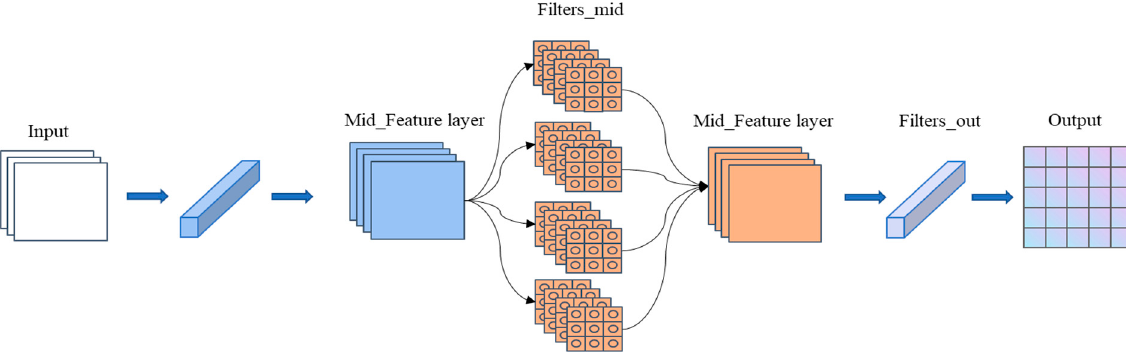
Figure 5. Depth-wise separable convolution (DSC) process.